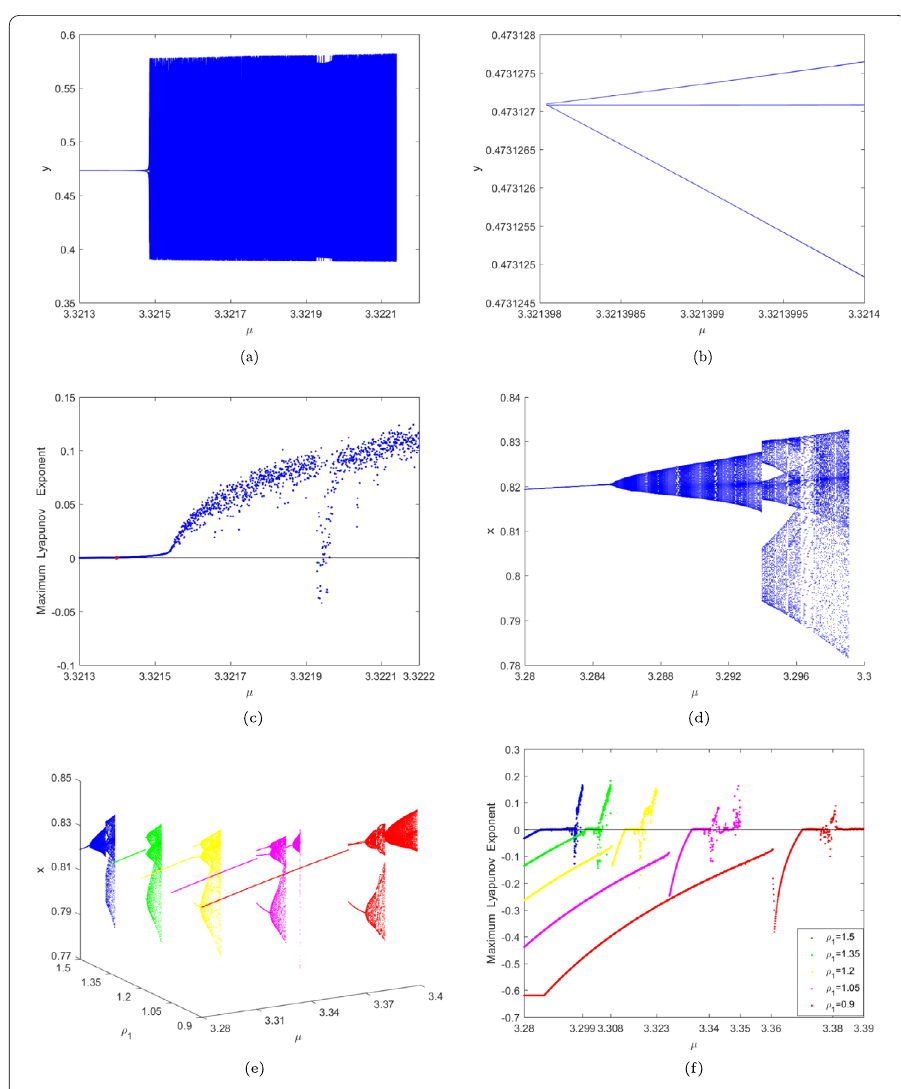
Figure 4 ( a ) Bifurcation diagram of map (2) in ( μ , y ) space for ρ 1 = 1.2, ρ 2 = 1.8, the initial point is (0.82795095,0.47312708). ( b ) Local amplification for μ ∈ [3.321398,3.3214] ( c ) MLE corresponding to (a). ( d ) Bifurcation diagram of map (2) in ( μ , x ) space for ρ 1 = 1.5, ρ 2 = 1.8 the initial point is (0.82,0.47). ( e ) Bifurcation diagram of map (2) in ( μ , ρ 1 , x ) space for ρ 2 = 1.8. ( f ) MLE corresponding to (e)